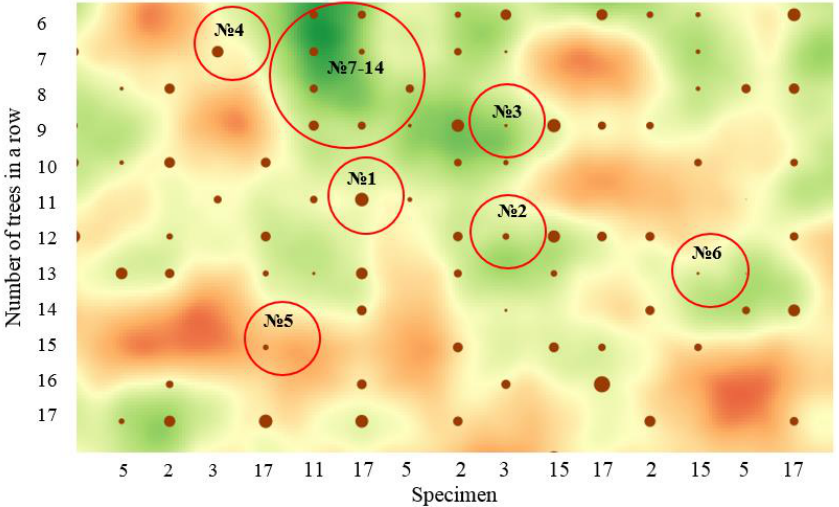
Figure 10. Arrangement of trees placement in an arbitrarily selected stand’s fragment (differences in the DBH are reflected by different sizes of circles). Drawing by A. Kaliszuk.